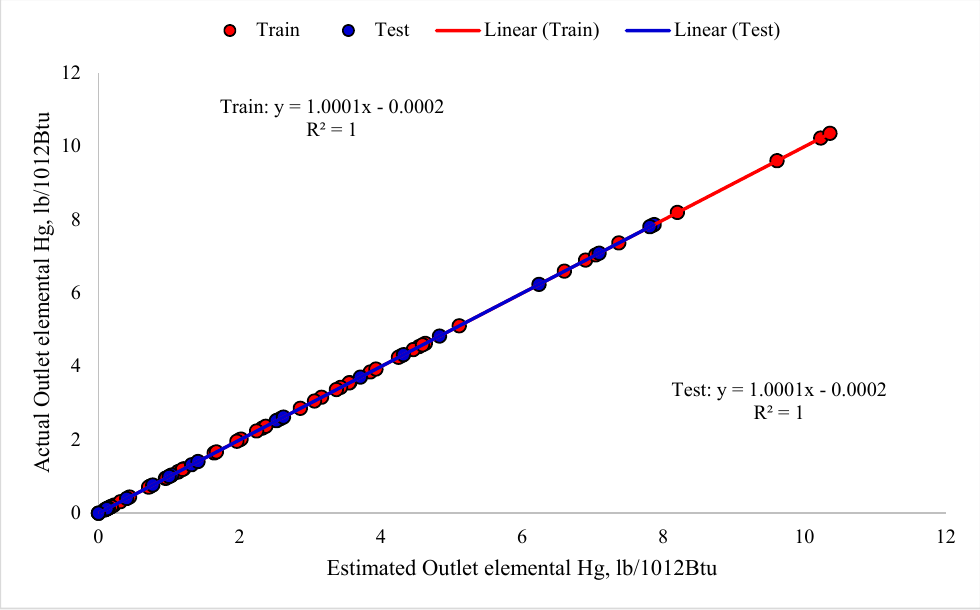
Figure 6. Regressions derived between the estimated and collected data on mercury emissions.